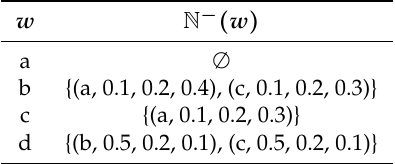
Table 2. IN-in-neighborhoods.